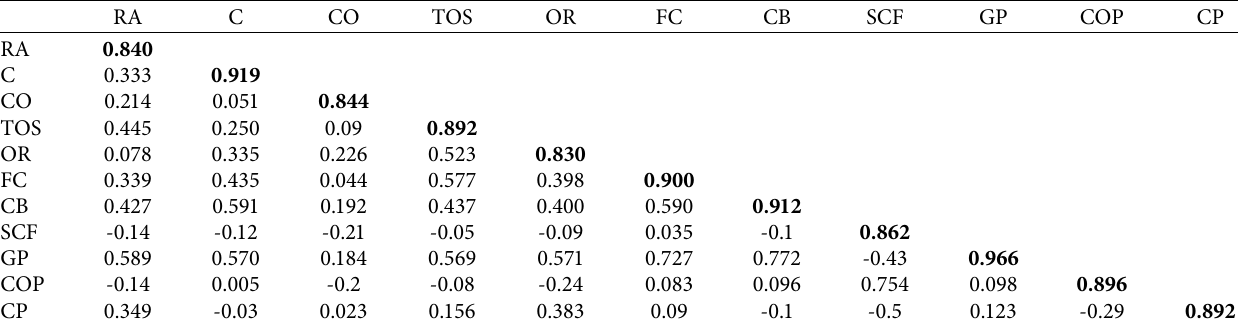
Table 10: Interconstruct correlation (discriminant validity) for private construction projects.